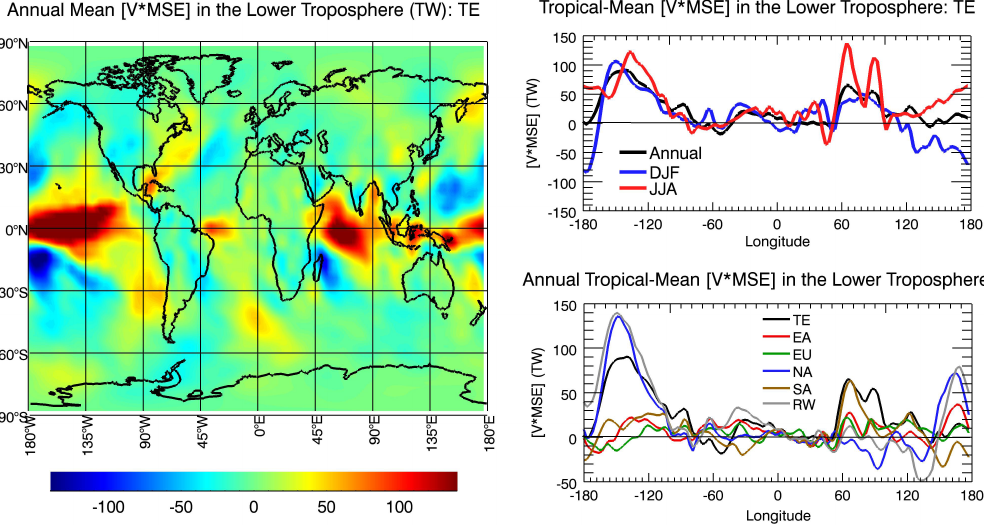
Fig. 5. Left panel: Annual mean meridional MSE flux accumulated over the 4 lowermost model layers as functions of longitude and latitude derived from the TE run. Upper panel on the right: Tropical mean (23S to 23N) of meridional MSE flux accumulated over the 4 lowermost model layers as annual mean, DJF mean, and JJA mean from the TE run. Lower panel on the right: The annual mean meridional MSE fluxes from different runs as accumulated values over the 4 lowermost model layers. The unit of MSE flux is in TW. All data are last 20-year